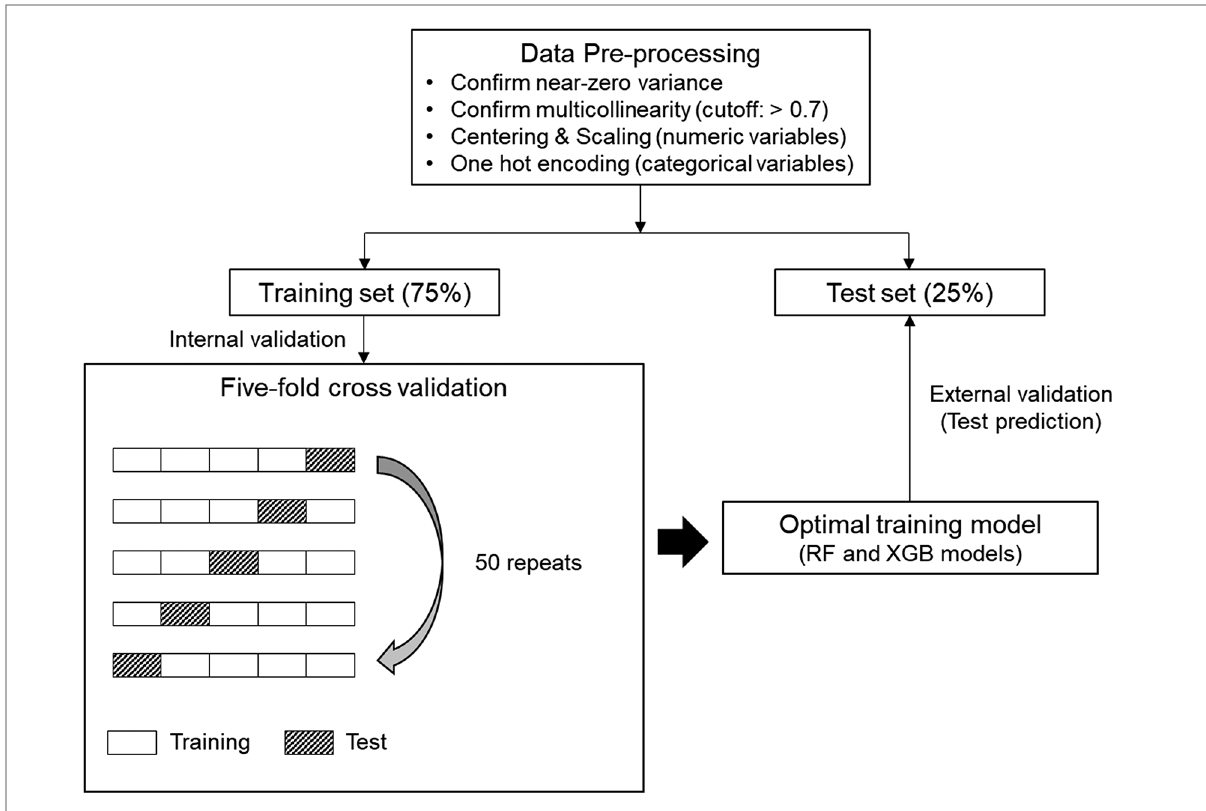
FIGURE 2 Machine learning (ML) process for this study. Five-fold cross-validation was repeated 50 times on the preprocessed training set to generate an optimal training model. Afterwards, test prediction was performed on the test set with the training model of each ML algorithm. RF, random forest; XGB, extreme gradient